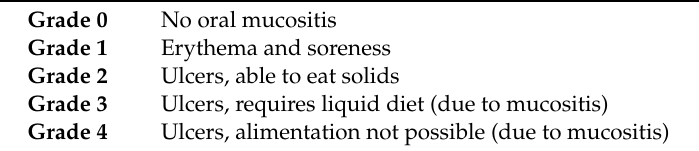
Table 1. The World Health Organization (WHO)scale for oral